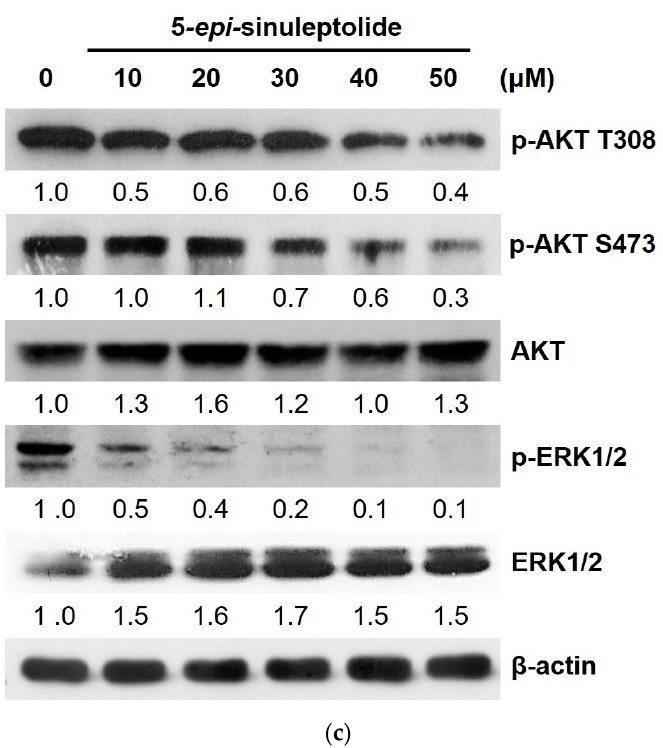
Figure 5. Cell invasion and JAK2/STAT3, AKT, ERK1/2 pathways are suppressed via 5- epi - sinuleptolide treatment. The invasiveness of cancer cells was examined via Matrigel invasion assays. PANC-1 cells were treated with 5 -epi -sinuleptolide at the indicated concentrations for 24 h. The invading cells were stained with DAPI and evaluated via fluorescent microscopy. Bars represent the mean of triplicate samples; error bars represent standard deviation. Data are representative of three independent experiments. * p < 0.05 and ** p < 0.01 versus cells with DMSO treatment ( a ). Rep- resentative Western blot bands showing protein expression of the endogenous and phosphorylated JAK2, STAT3, AKT, and ERK1/2 levels in BxPC-3 cells treated with indicated concentrations of 5- epi -sinuleptolide. DAPI, 4 ′ ,6-diamidino-2-phenylindole; JAK2, Janus kinase 2; p-JAK2, phosphory- lated JAK2; STAT3, signal transducer and activator of transcription 3; AKT, protein kinase B; and ERK1/2, extracellular signal-regulated kinase 1/2 ( b , c ). The numbers under each blot represent val- ues of corresponding band intensity relative to that of actin and untreated control.